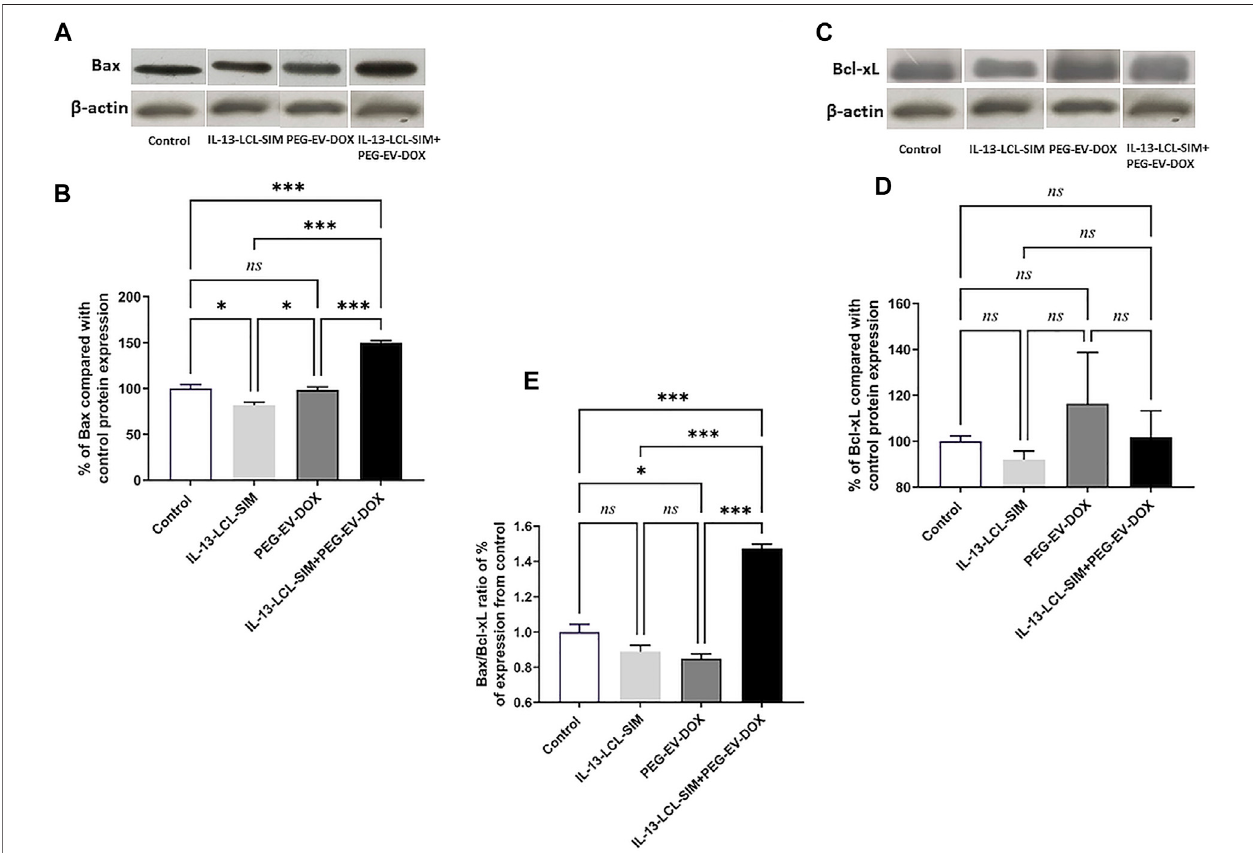
FIGURE 7 | Evaluation of the effect of the treatments on key apoptotic protein levels in TME. The effect of different treatments on intratumor levels of Bax (A) and Bcl-xL (C) wereevaluatedbyWB. β -Actinwasusedasloadingcontrol.TheproteinlevelsofBax (B) andBcL-xL (D) intumorlysateswereexpressedaspercentage from the control, untreated group. (E) Ratio of % expression levels of Bax/Bcl-xL compared to control. One-way ANOVA test with Bonferroni correction for multiple comparisons wasperformed to analyze thedifferences betweenthe effects of thetreatmentson the apoptotic proteins. Control, untreated group; IL-13-LCL-SIM, group treated with 5 mg/kg IL-13-LCL-SIM on days 7 and 10 after tumor cell inoculation; PEG-EV-DOX, group treated with 2 mg/kg PEG-EV-DOX on days 8 and 11 after tumor cell inoculation; IL-13-LCL-SIM + PEG-EV-DOX, the group received the nano-formulations sequentially, IL-13-LCL-SIM 5 mg/kg on days 7 and 10, respectively,andPEG-EV-DOX2 mg/kgondays8and11aftertumorcellinoculation; ns , p > 0.05;*, p < 0.05;and***, p < 0.001.TheuncroppedimagesofBax,Bcl-xL, and β -actin blots are presented in the supplementary information fi